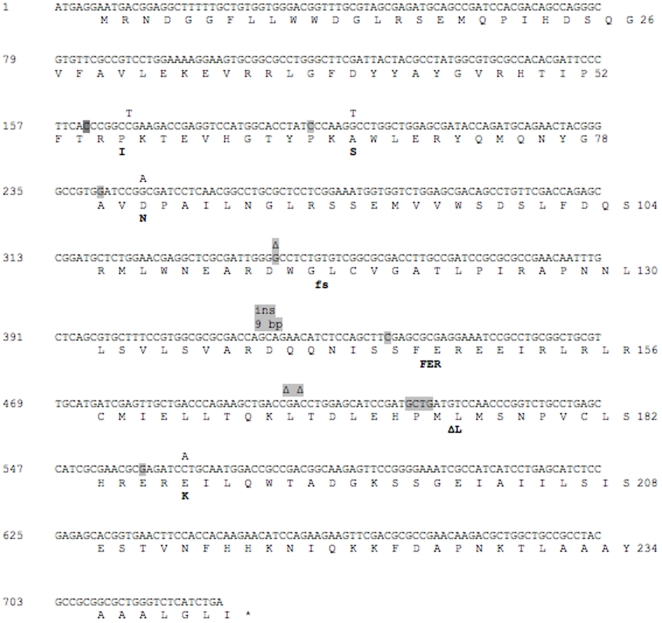
Mutations in the rhlR gene of P. aeruginosa isolates from CF patients.The nucleotide sequence alterations were identified by alignment with the PAO1 sequence. On top of the PAO1 sequence the nucleotide substitutions, insertions (ins) or deletions (Δ) are indicated. Under the amino acid sequence, frame shifts (fs), stop codons(*) or amino acid deletions (Δ) or changes are indicated in bold.